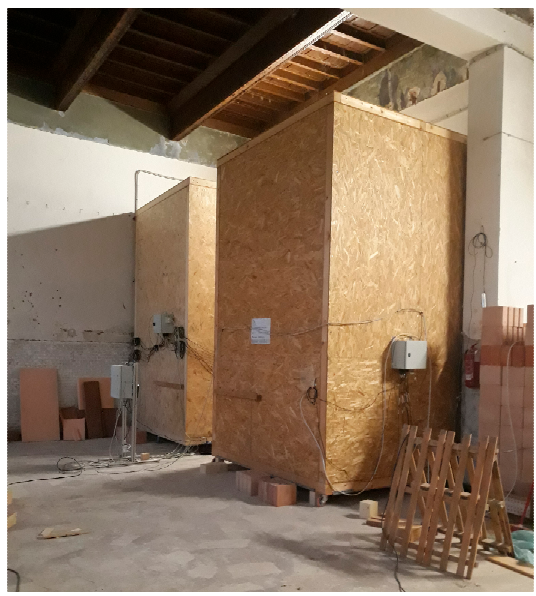
Figure 5. Internal view of the room, with the two boxes tied up to the studied wall.